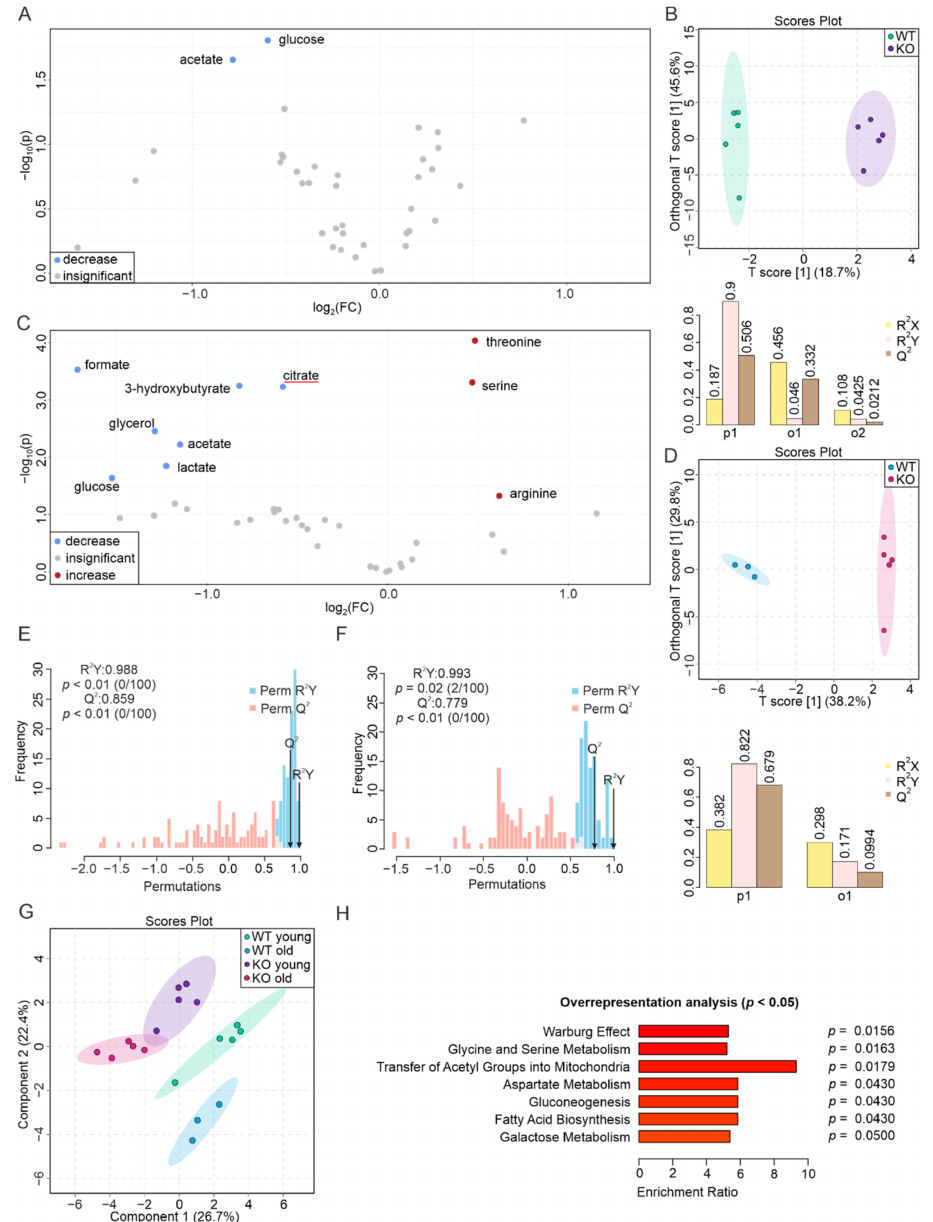
Figure 5. Metabolic alterations in WAT of young and aged PEMT KO mice. ( A ) Volcano plot showing differences in the metabolic profiles of WT and PEMT KO WAT from young mice. Red, blue, and grey dots indicate significantly increased, decreased, and insignificantly changed metabolites, respectively. ( B ) O-PLS-DA plot of WT ( n = 5, green) and KO ( n = 5, purple) WAT samples from young mice (upper panel), and model quality assessment for p1, o1, and o2 with cross-validation coefficients R 2 X, R 2 Y, and Q 2 (lower panel). ( C ) Volcano plot showing differences in the metabolic profiles of WT and PEMT KO WAT from aged mice. Red underline indicates an aging biomarker whose concentration increases in the aged WT WAT. ( D ) O-PLS-DA plot of WT ( n = 3, blue) and KO ( n = 5, pink) WAT samples from aged mice (upper panel), and model quality assessment for p1 and o1 with cross-validation coefficients R 2 X, R 2 Y, and Q 2 (lower panel). ( E ) Permutation test of samples in ( B ) and ( F ) samples in ( D ) with permutation number n = 100, respectively. ( G ) S-PLS-DA plot of the 4 WAT groups, with green, purple, blue, and pink corresponding to WT young, KO young, WT old, and KO old, respectively. ( H ) ORA of pathways associated with significantly changed metabolites in the WAT of aged mice ( C ), with all pathways yielding p <